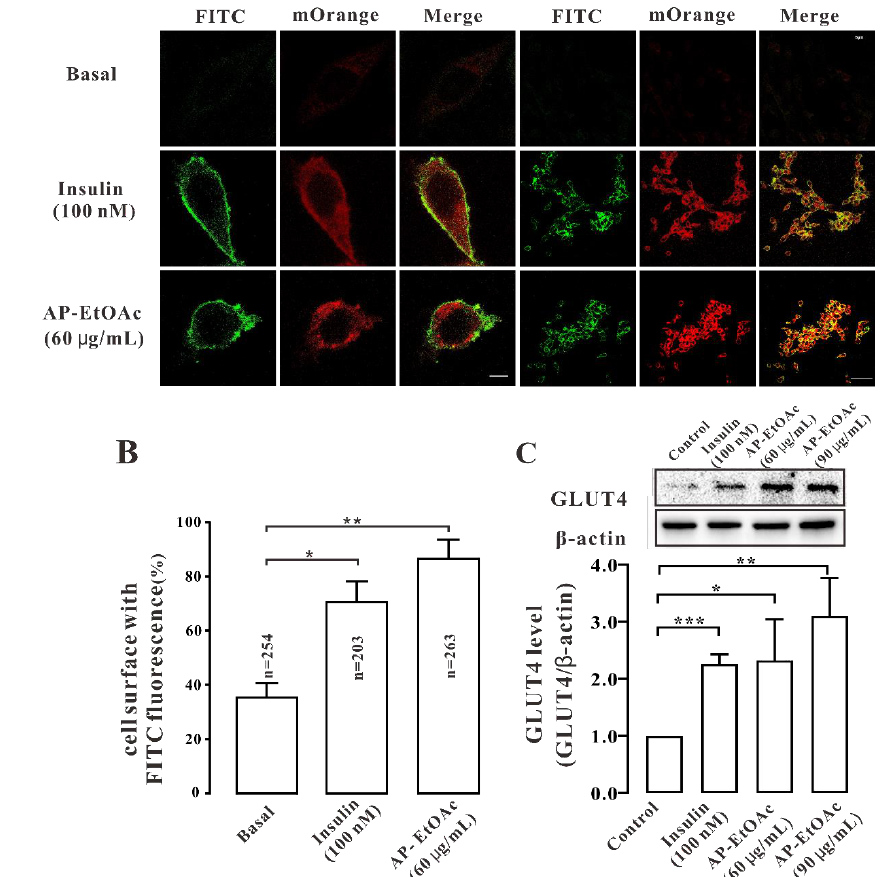
Figure 3. AP-EtOAc enhanced GLUT4 protein expression and GLUT4 fusion with the plasma membrane in L6 cells. ( A ) FITC fluorescence assay in myc-GLUT4-mOrange cells treated with 60μg/mL AP-EtOAc or 100 nM insulin. Scale bar: 5 μm in single cell image, 50 μm in multi-cell image. ( B ) Number of GLUT4-mOrange-positive cells, the data represent the mean ± s.e.m. of values from three separate experiments with between 200 and 300 cells being examined in each experiment. ( C ) The expression level of GLUT4 after treated with 100 nM insulin or different concentrations of AP-EtOAc for 30 min in L6 cells. The control group was considered as 1 for data analysis. The data represent the mean ± s.e.m. of values from three separate experiment. *: p < 0.05; **: p < 0.01, ***: p < 0.001.